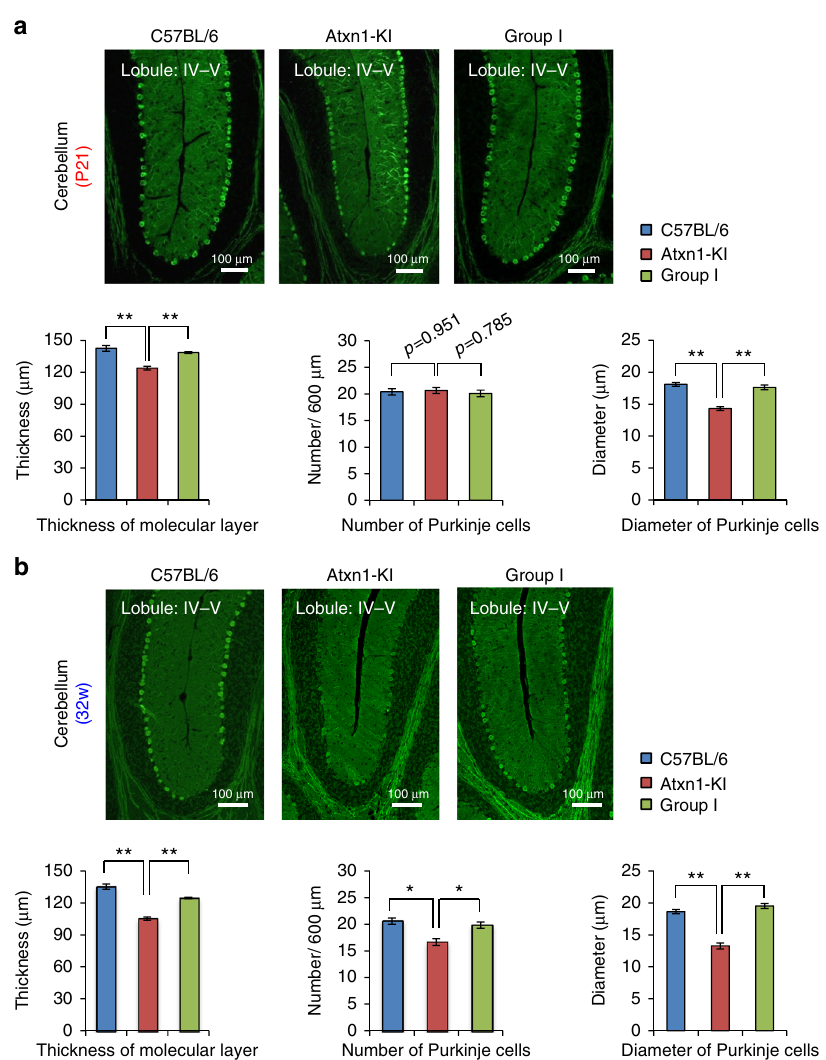
Fig. 2 Morphological changes precede cell death in Purkinje cells at P21. a Upper panels are low-magni fi cation images of the cerebellar cortex in three mouse groups at P21. Sections were immunostained with anti-calbindin antibody. The number of Purkinje cells in 600 μ m of the primary fi ssure side of lobule IV – V was counted in one slide, and the values from 20 slides from four mice ( fi ve per mouse) were used for statistical analysis. To determine the thickness of the molecular layer, the thickness was measured at six regions on the primary fi ssure side of lobule IV – V per slide, and the values from 120 regions from 20 slides from four mice were used for statistical analyses. The diameter of Purkinje cells was measured for all Purkinje cells on the primary fi ssure side of lobule IV – V, and the values from 20 slides from four mice were directly used for analysis. Lower graphs show quantitative analyses of the thickness of the molecular layer, the number of Purkinje cells, and the diameter of Purkinje cells. Double and single asterisks indicate statistical signi fi cance ( p < 0.01 and p < 0.05, respectively) in one-way ANOVA with post hoc Tukey ’ s HSD test. Four mice were used for analyses; 20 slides were made from each mouse; and 50 Purkinje cells were measured in total. b Analysis as described for a , at 32 weeks of